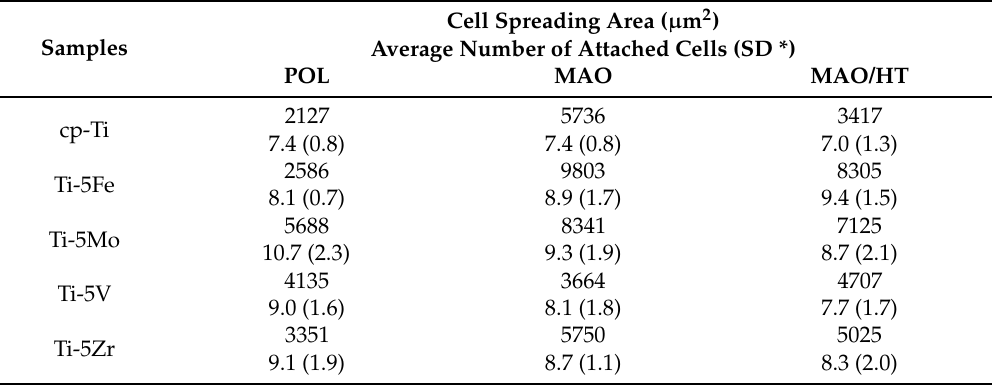
Figure 9. Representative cell adhesion images: (left) SEM images after the incubation of MG-63 cells for 3 h on POL-, MAO-, and MAO/HT-treated sample surfaces and (right) their cell spreading images obtained using ImageJ software analysis. Table 6. Cell spreading areas in Figure 9 and the average number of attached cells measured at 170 µ m ˆ 250 µ m ( n = 7) after incubation of MG-63 cells for 3 h on POL-, MAO-, and MAO/HT-treated sample